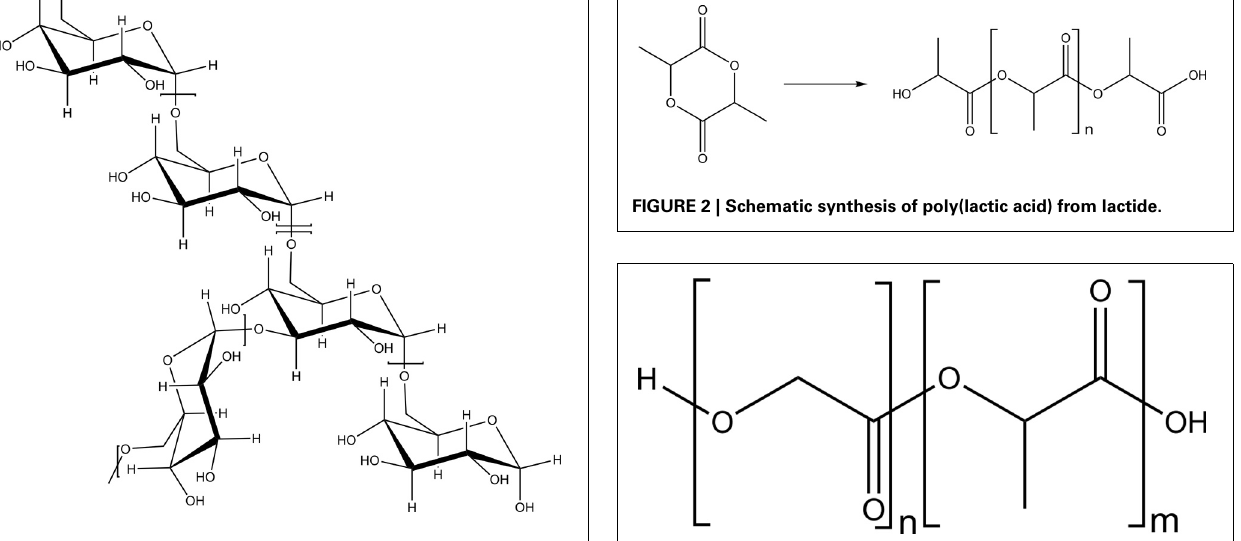
FIGURE 1 | Dextran as an example of a branched polysaccharide with multiple hydroxyl groups as functional moieties.